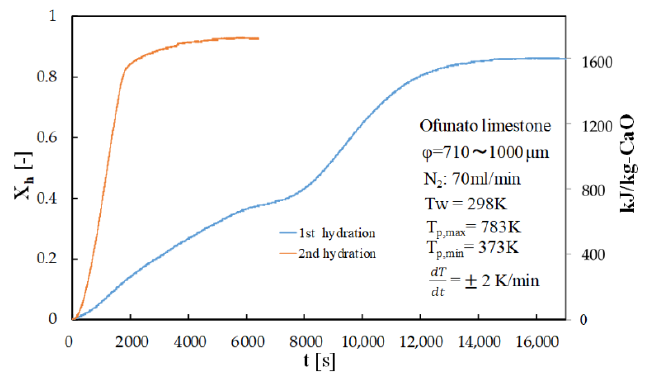
Figure 8. Hydration conversion of Ofunato CaO in TGA-51 after decarbonization at 1223 K for 5 h in muffle furnace.